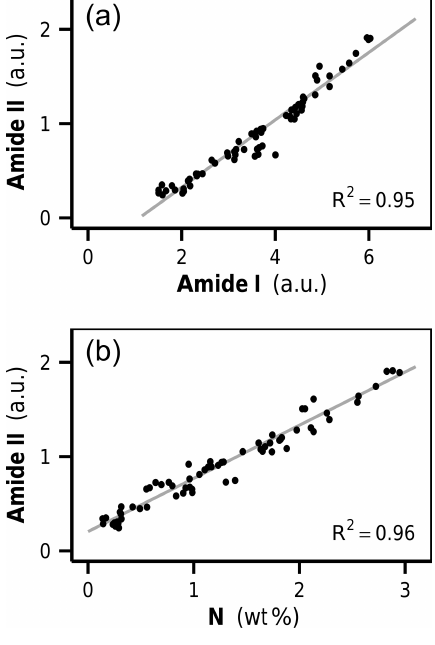
Figure 4. (a) Correlation between amide I and amide II over all undecomposed and decomposed litters, and (b) the correlation be- tween bulk litter N content and amide II. a.u.: arbitrary